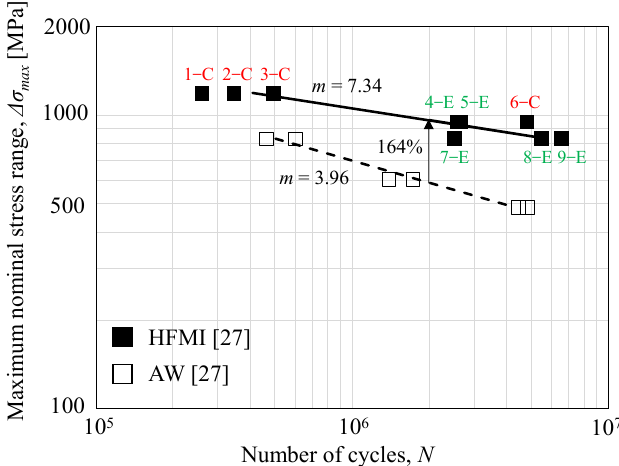
Figure 7. Fatigue test results of S690QL in AW and HFMI conditions. Table 3. Fatigue test results and fracture observation of S690QL in HFMI condition.